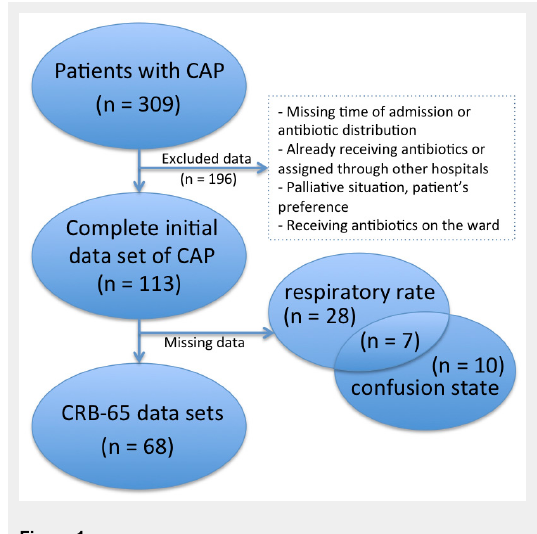
Flow chart of CRB-65 data set obtained from patients with community acquired pneumonia